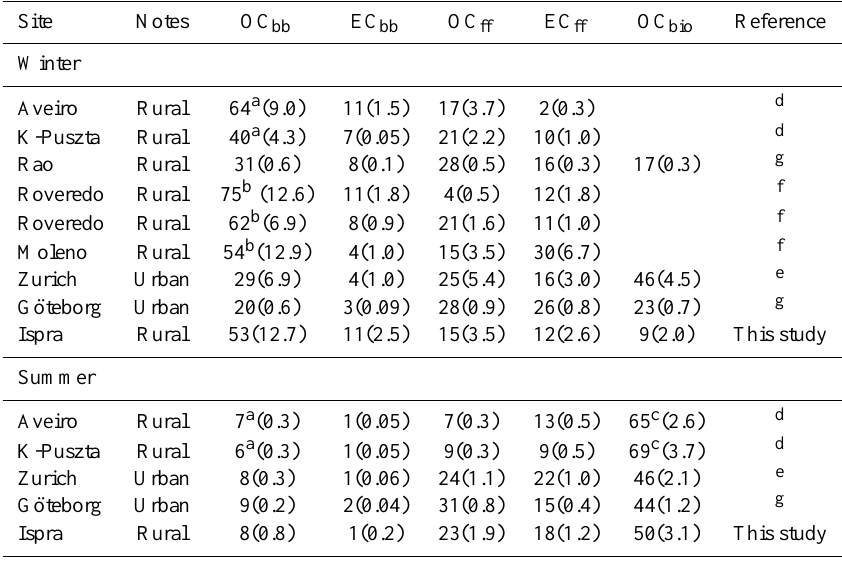
Table 5. Percentage values of TC emitted by biomass burning (bb), fossil sources (ff) and biogenic sources (bio), together with average carbon concentration in µgm − 3 between